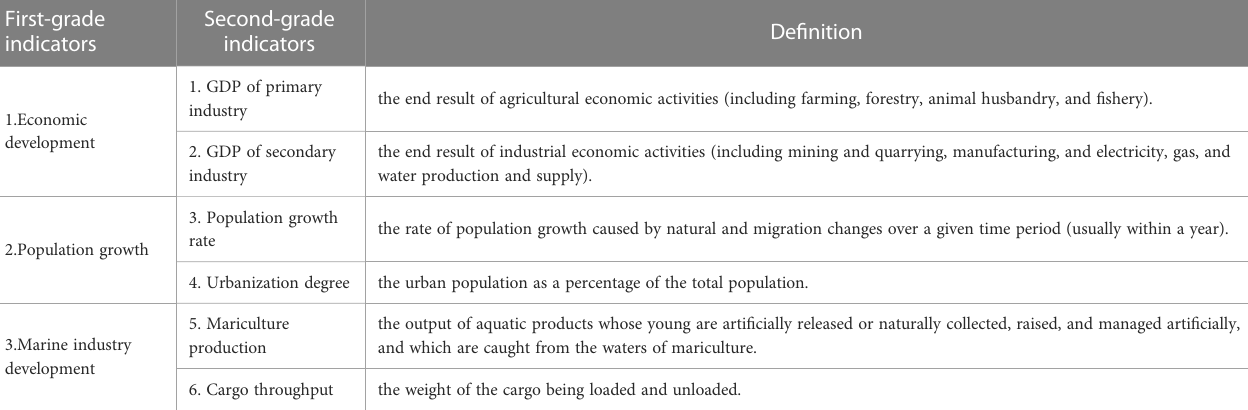
TABLE 3 Evaluation index system of the driving force factors of the reclamation. First-grade indicators